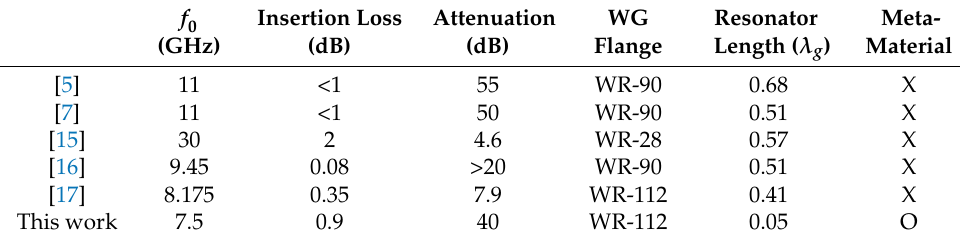
Table 8. Comparing the characteristics of the proposed filter and others’ filters.